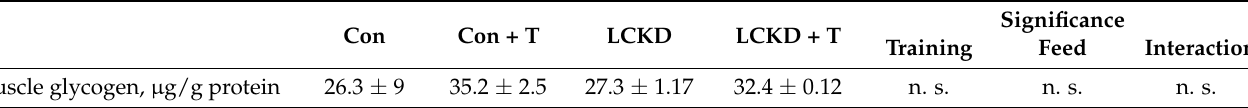
Table 6. The effect of LCKD feeding and/or training on muscle glycogen content.